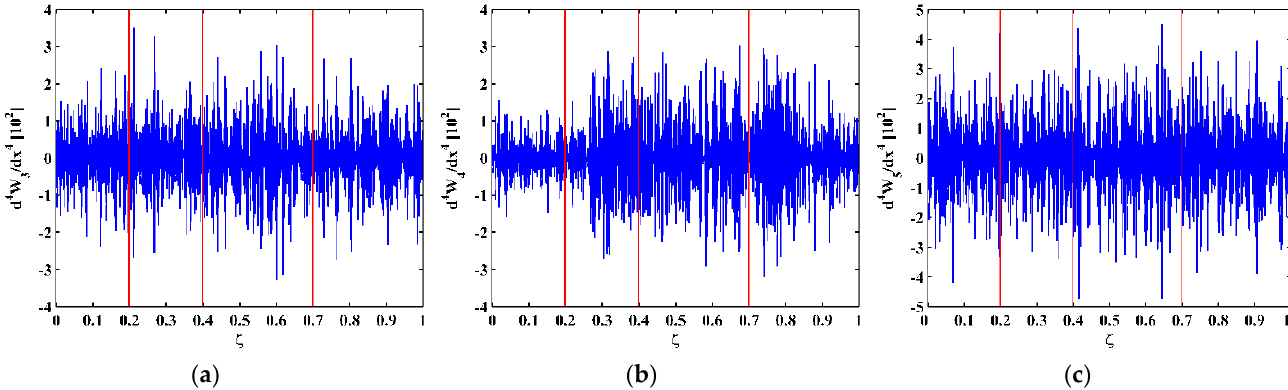
Figure 5. Derivatives of the ( a ) third, ( b ) fourth, and ( c ) fifth mode shapes (locations of cracks are indicated by red lines).